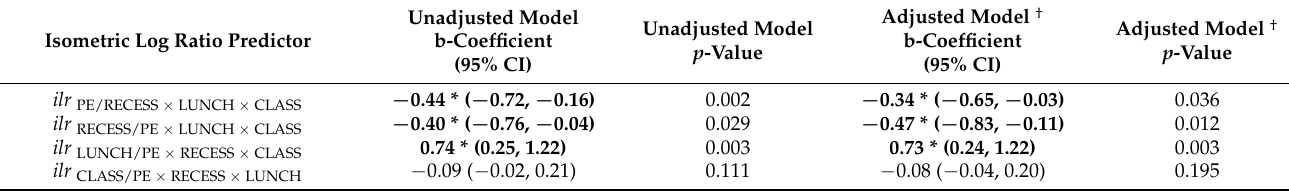
Table 2. Parameter estimates from the Body Mass Index z-score naïve and general linear mixed effects regression models using compositional data analysis. Isometric Log Ratio